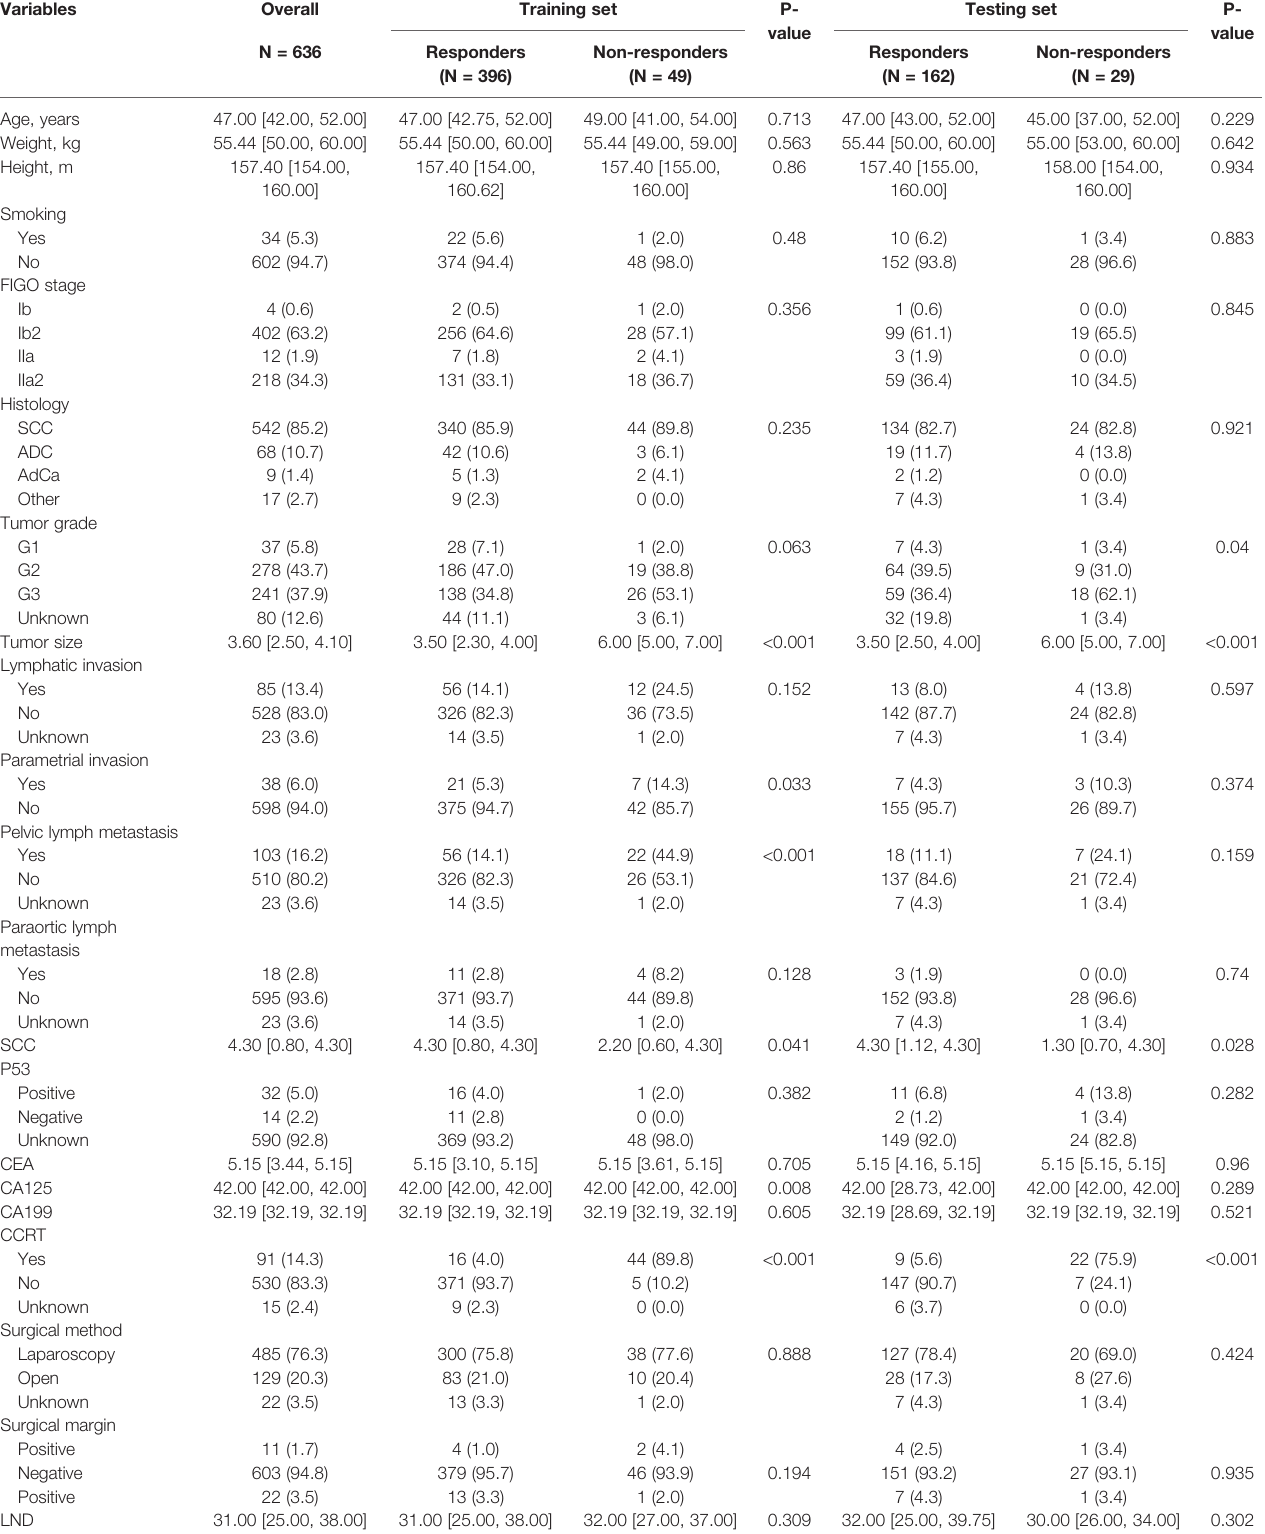
TABLE 1 | Baseline demographic and clinicopathologic features of patients with LACC with and without a diagnosis of rNACT.